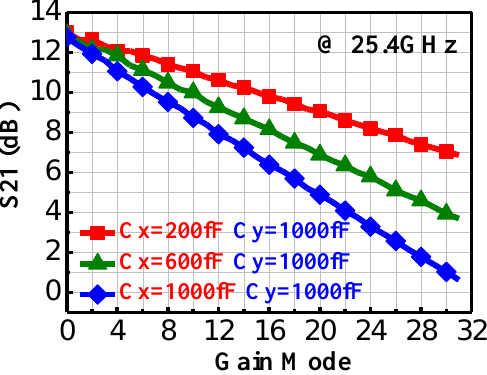
Figure 10. Measured gains versus gain mode under different control modes at 25.4 GHz.